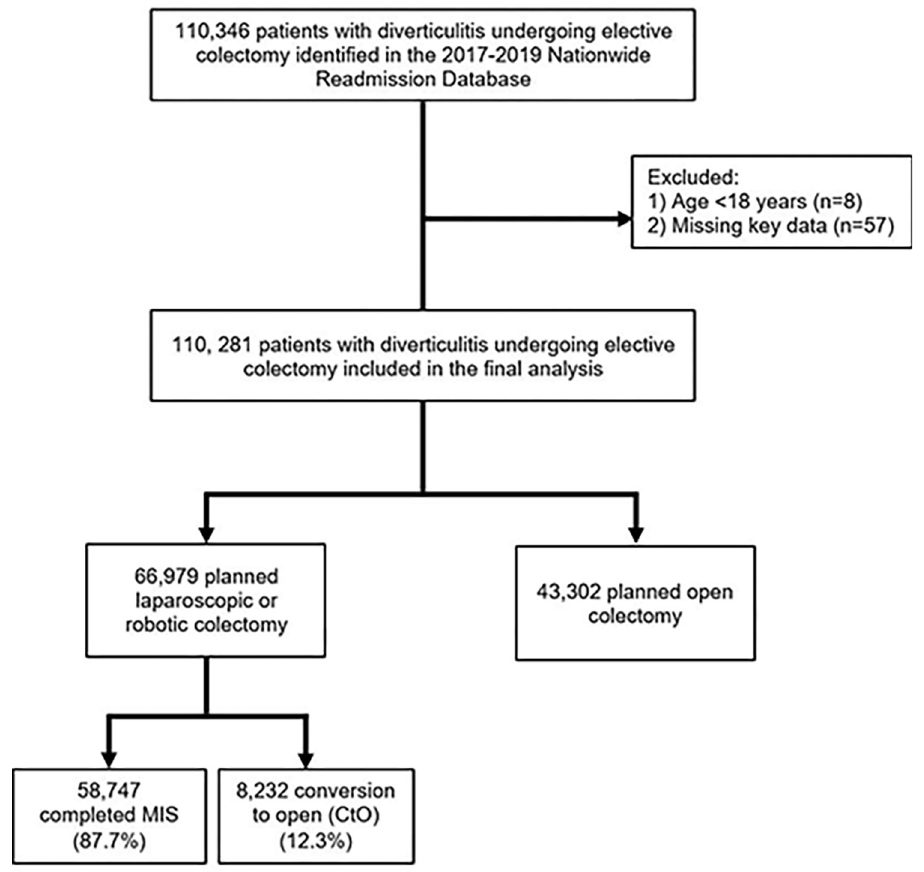
Fig 1. Flow chart of the patient population selection